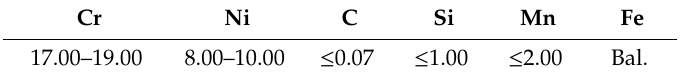
Table 1. Chemical composition of stainless steel 1.4301 in mass % according to DIN EN 10088-3. Cr Ni C Si Mn Fe 17.00–19.00